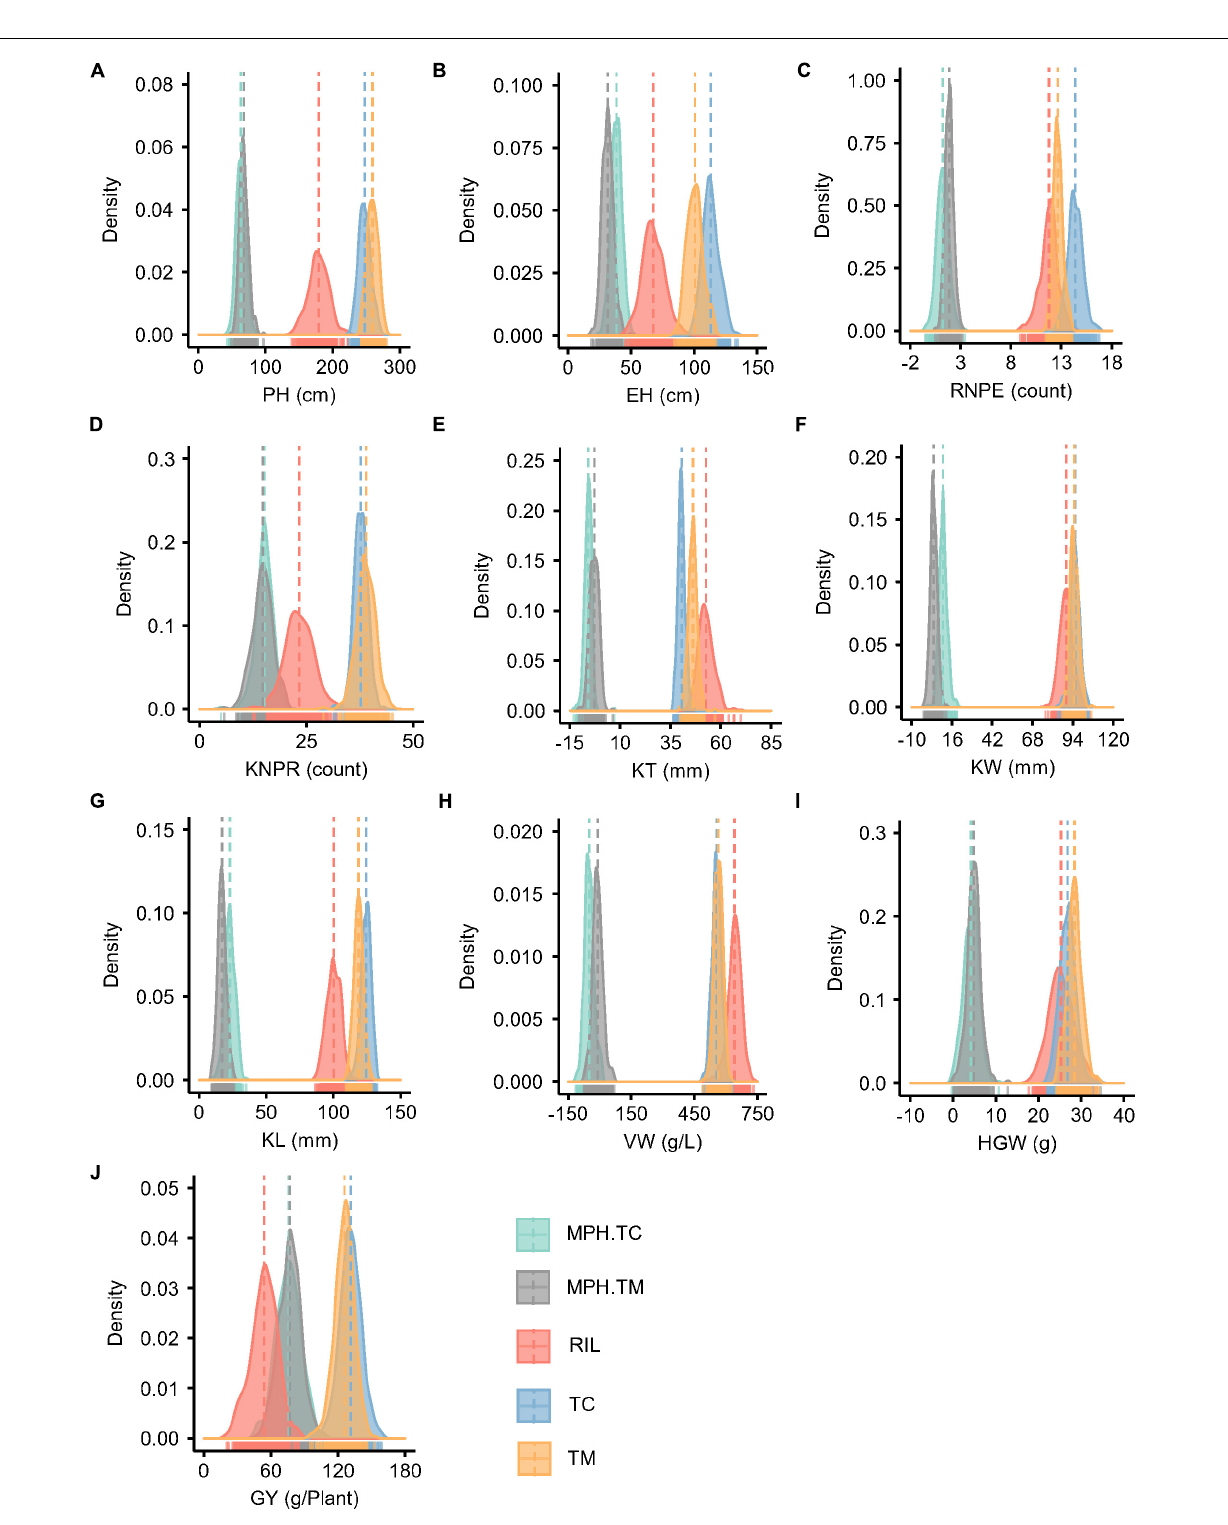
Frontiers in Plant Science |